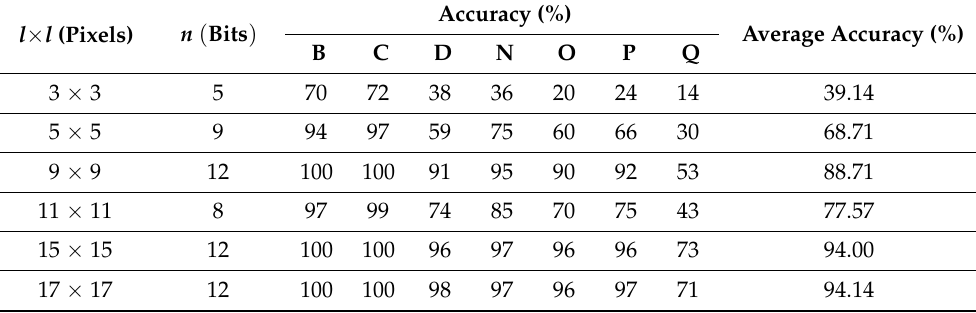
Table 1. ComparisonoftheresultsobtainedusingsixBSIFconfigurationswithchangesinfacialexpression. l × l